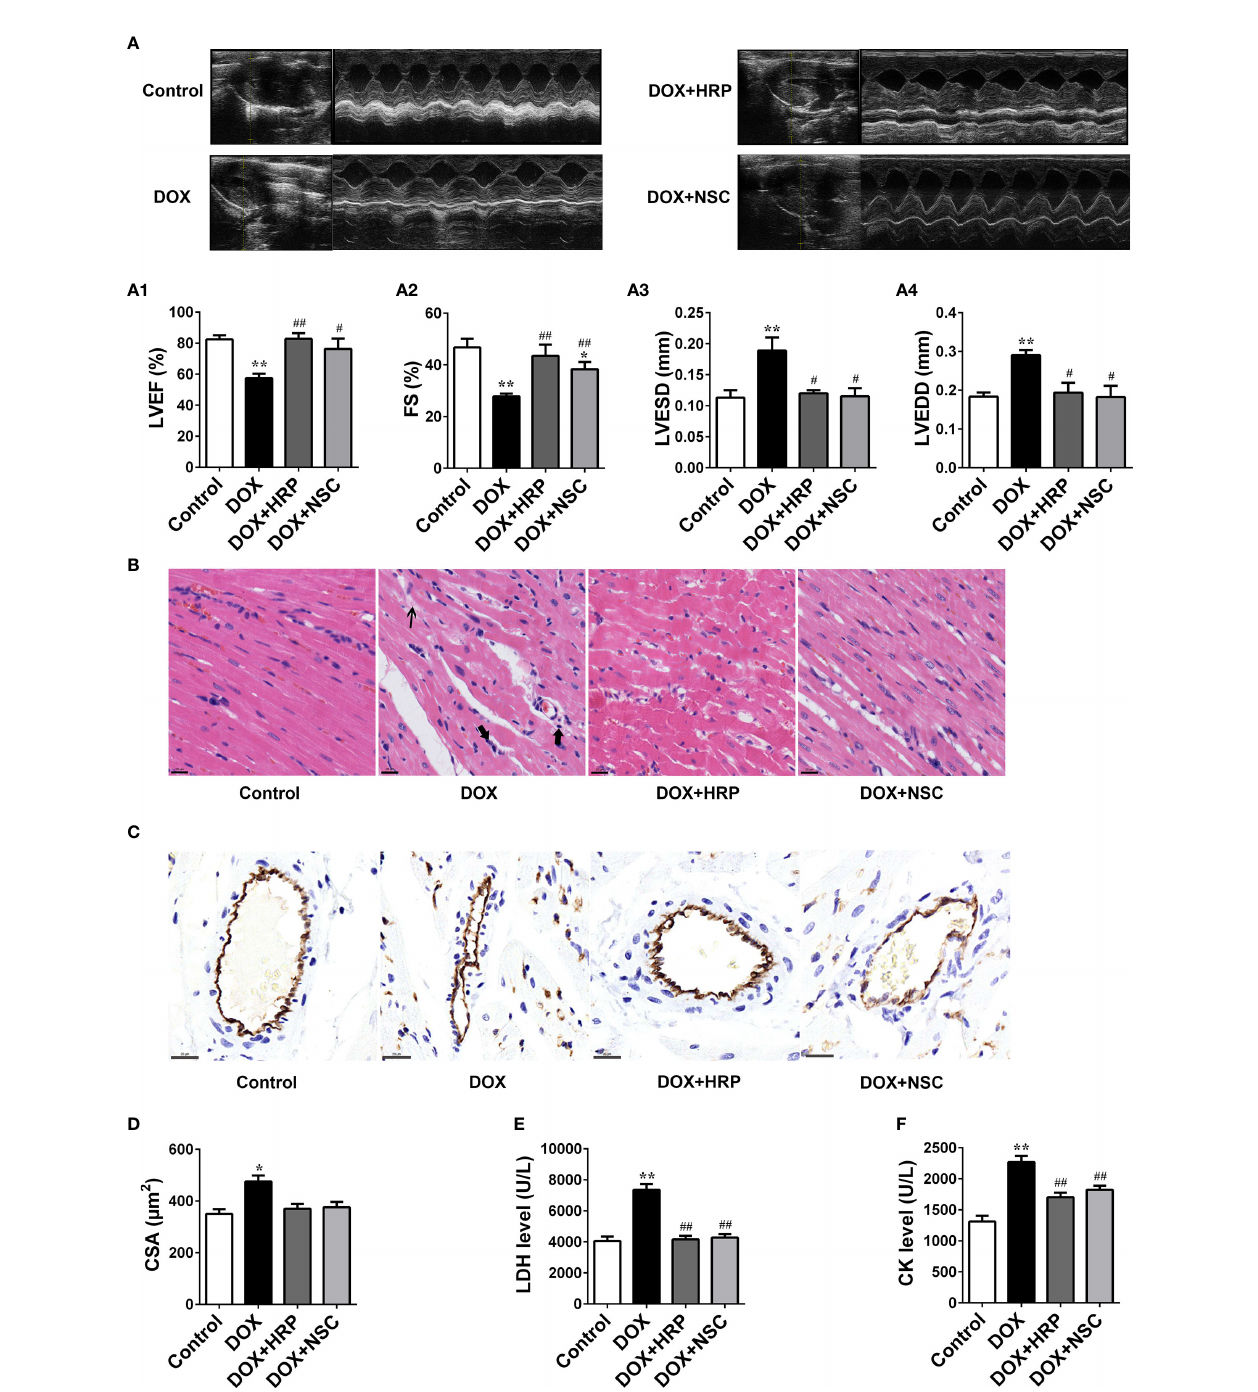
FIGURE 5 | Therapeutic effect of PRR/RAC1 inhibition on doxorubicin-induced HF in rats. Protective effects of pharmacological (pro)renin receptor (PRR) inhibition on doxorubicin (DOX)-induced cardiac hypertrophy and dysfunction. (A) Representative M-mode left ventricle (LV) echocardiogram. (A1) Left ventricular ejection fraction (LVEF). (A2) Fractional shortening (FS); (A3) left ventricular end-systolic diameter (LVESD). (A4) left ventricular end-diastolic diameter (LVEDD). (B) Representative photomicrographs of hematoxylin-eosin stained left ventricle (LV) sections. The structure of dysregulated myocytes is marked as thin arrowhead, in fl ammatory cell in fi ltration marked as thick arrowhead. (C) Representative photos of CD31 immunohistochemical staining in each group. Scale bars: 20 m m. (D) Cross-sectional areas (CSA) of cardiomyocytes in the LV. (E, F) Serum levels of LDH and CK in rats. Data are presented as the mean ± SEM. * p < 0.05 and ** p < 0.01 vs control; # p < 0.05, ## p < 0.01 vs the DOX